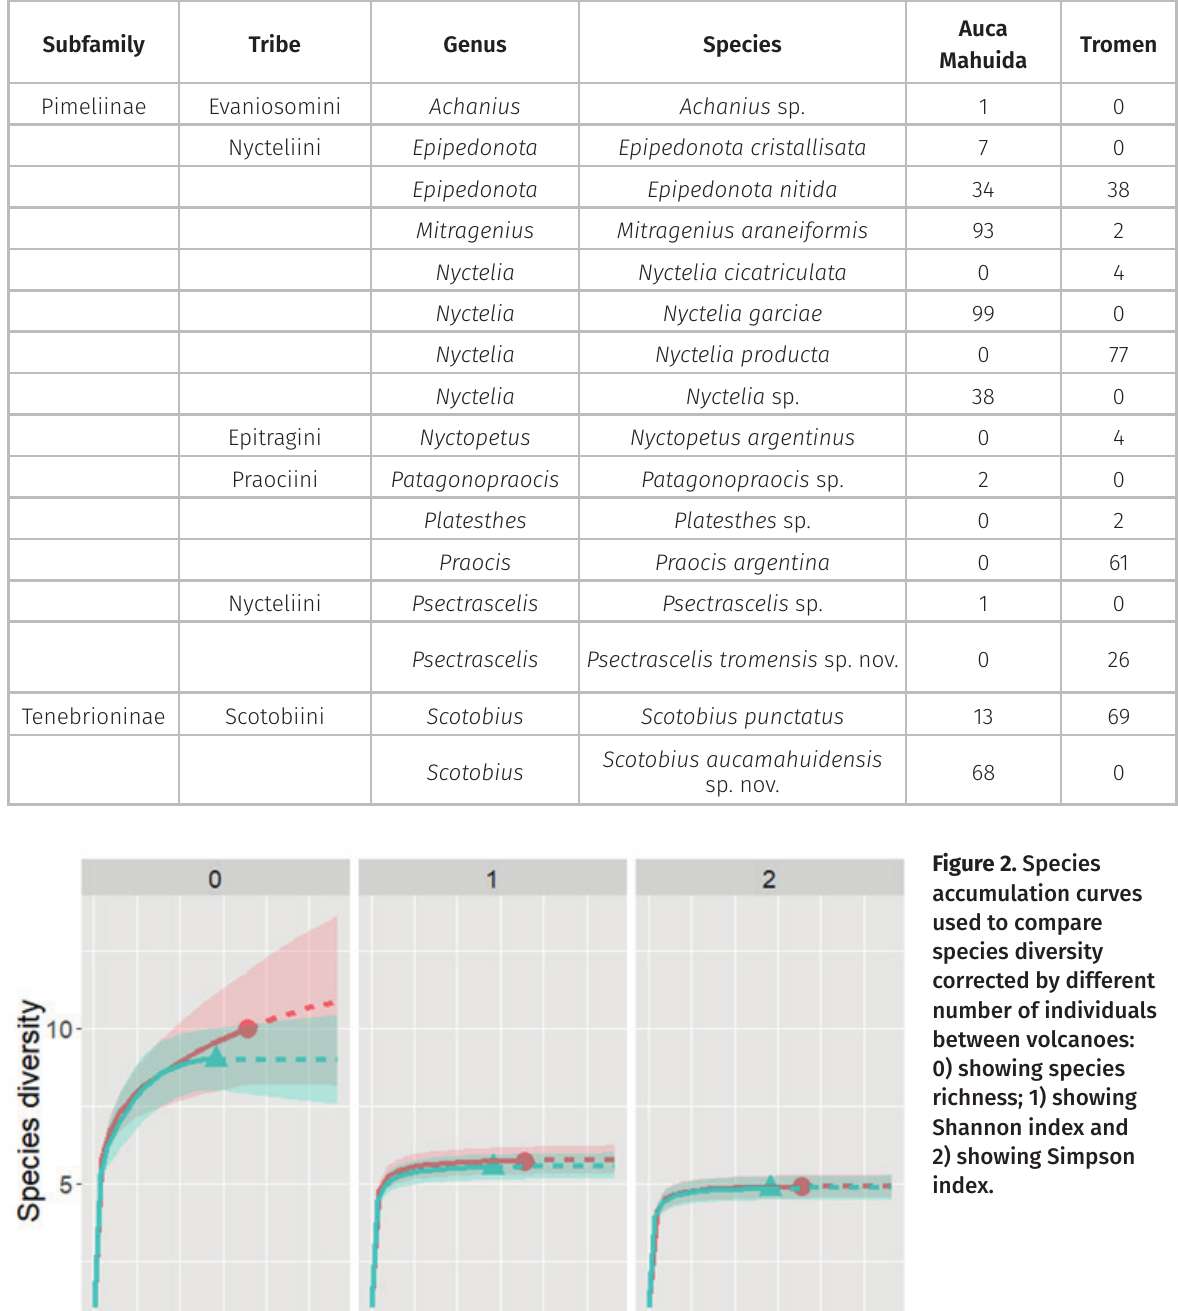
Table I. List of species with their taxonomic position and number of individuals found in each volcano. Subfamily Tribe